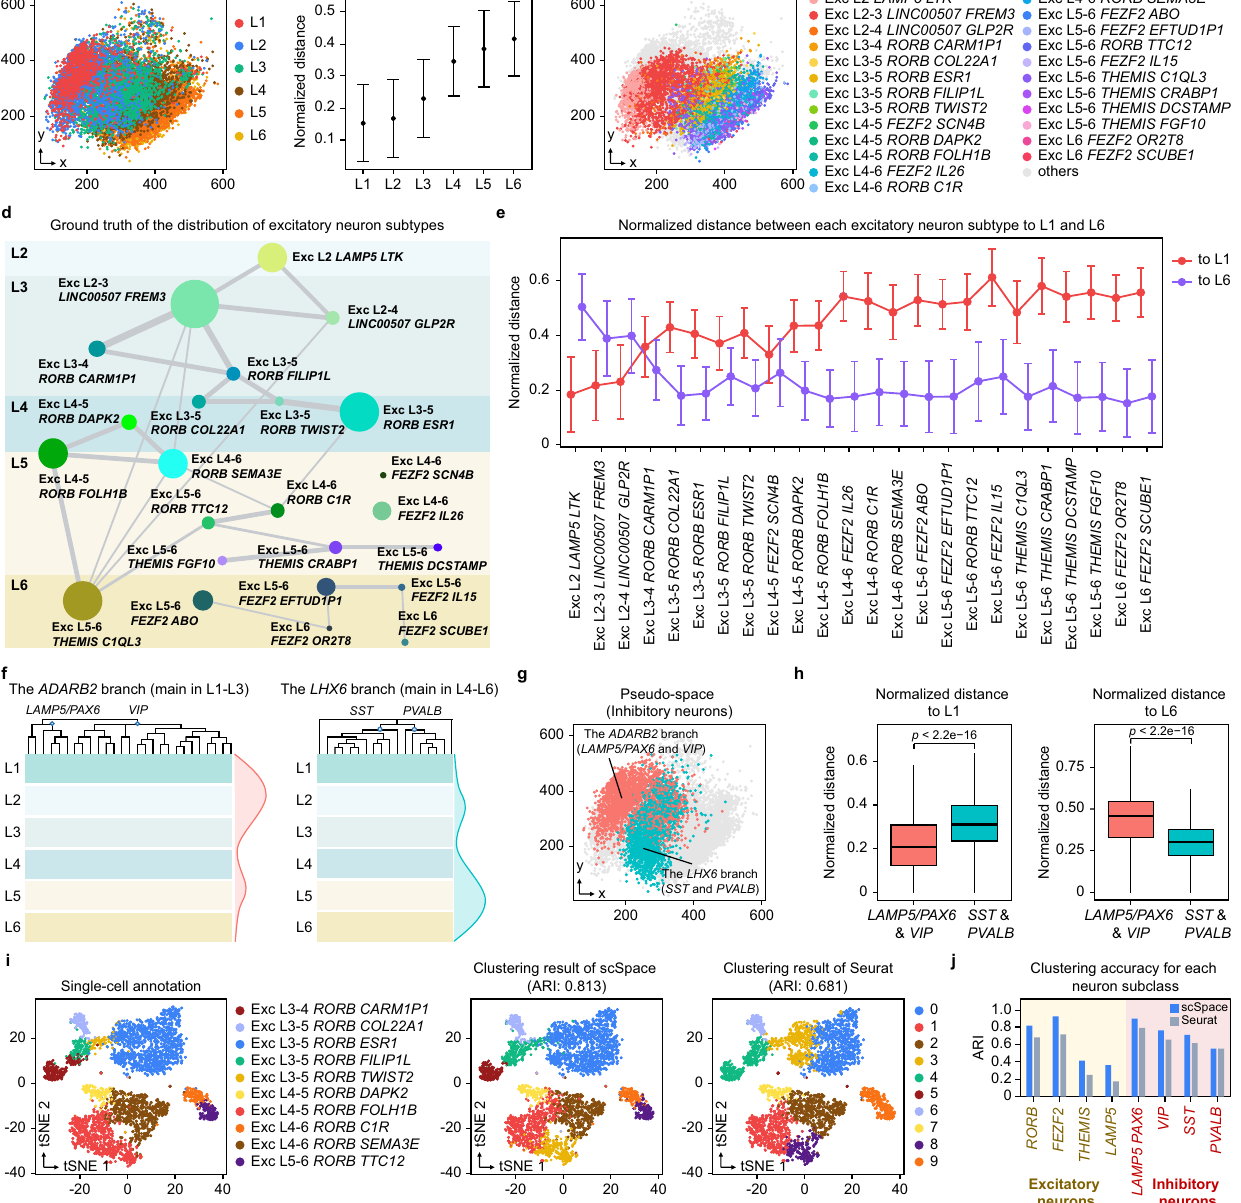
2,095,569, 67,425, 431,520, 927,768, 450,399, 396,459, 142,941, 210,366, 846,858, 151,032, 1,005,981, 4,145,289, 51,243, and 140,244, respectively. f Schematic of average layer positions for two branches of inhibitory neuron subclasses. g Spatial distribution of inhibitory neuron subclasses in the pseudo-space. All other sub- classes are colored with gray. h Normalized pairwise distance between different Inhibitory neuron subclasses to L1 (left) and L6 (right). Data are presented as boxplots (minima, 25th percentile, median, 75th percentile, and maxima). The number ofdata points (to L1) is 2,496,320 and 1,984,144, respectively; the number ofdatapoints(toL6)is6,257,040and4,973,268,respectively. P -valueiscalculated withthetwo-sidedWilcoxonrank-sumtest(theexact P -valuesfromlefttorightare both 0). i t-SNE visualization of 10 RORB-expressing excitatory neuron subclasses, colored by the single cell annotation obtained from the original publication (left), the clustering result of scSpace (middle), and Seurat (right). j Comparison of the clustering accuracies between scSpace and